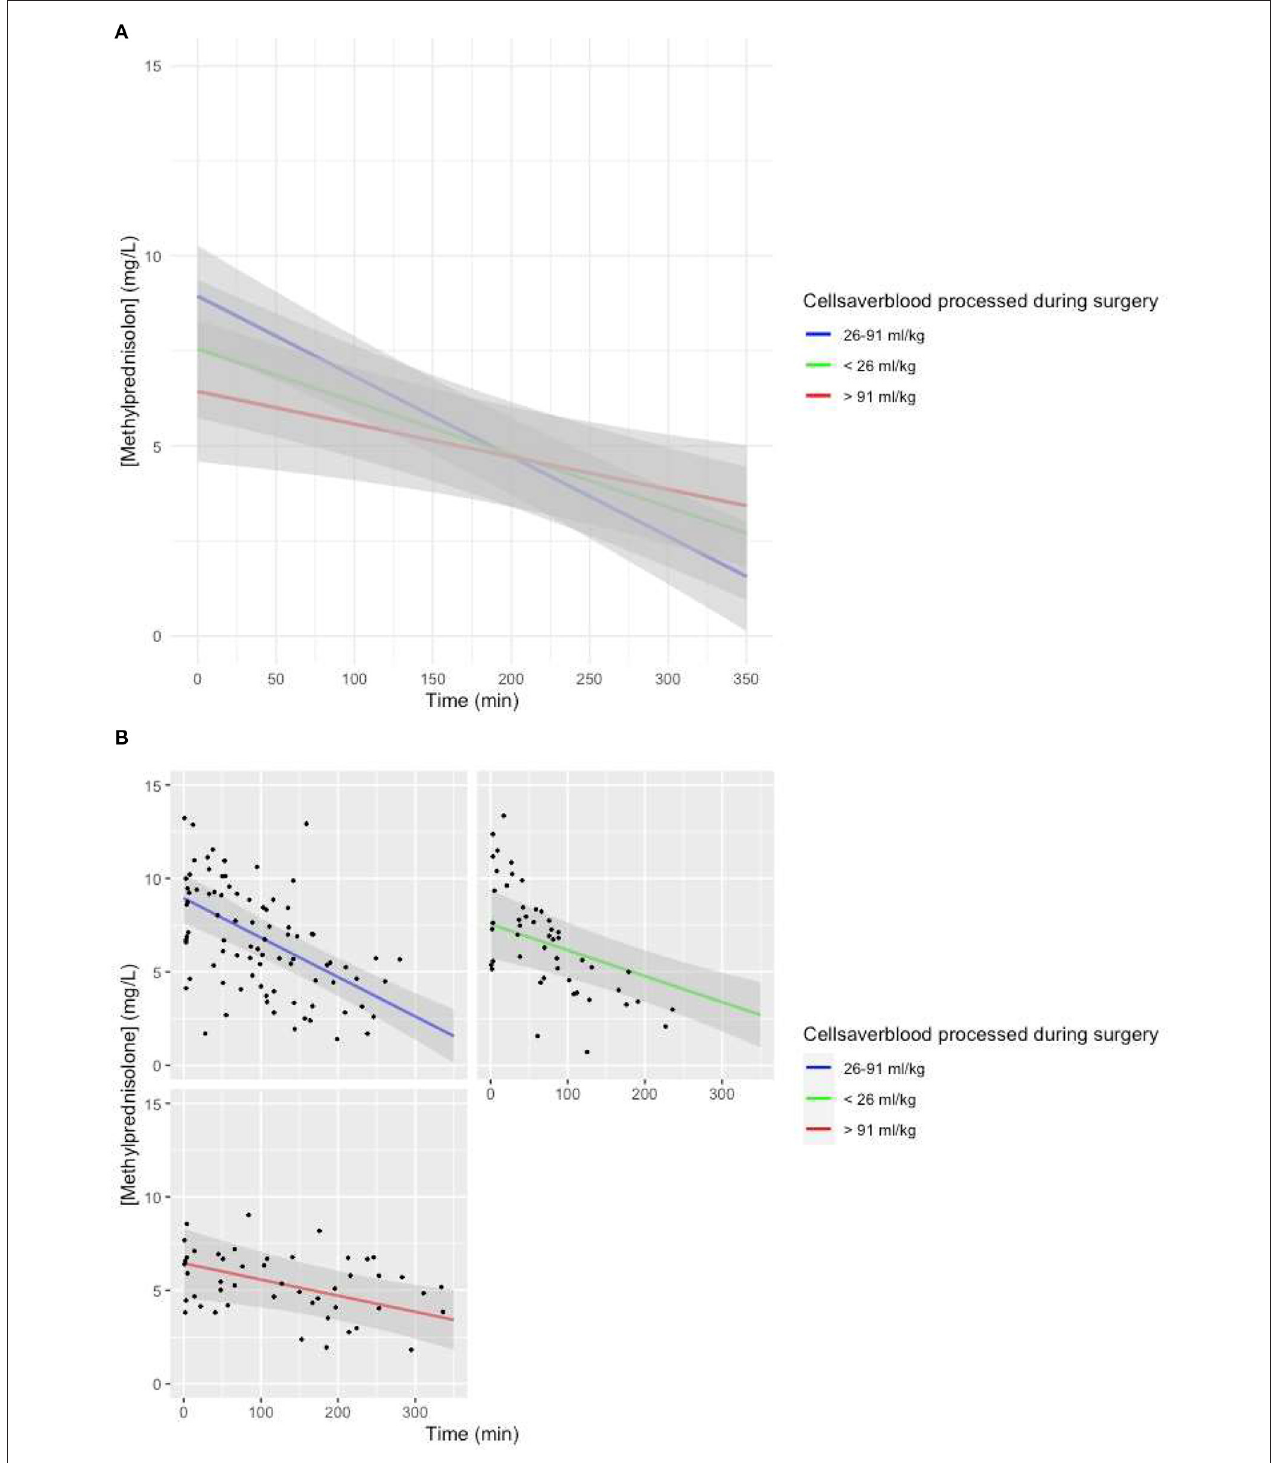
FIGURE 5 | (A) Predicted MP concentration (mg/L) vs. time (min) for the volume of cell saver blood processed based on the linear mixed-effects model. Gray ribbon: 95% confidence interval. T = 0: start of CPB. (B) Predicted MP concentration (mg/L) vs. time (min) for the volume of cell saver blood processed based on the linear mixed-effects model. Gray ribbon: 95% confidence interval. T = 0: start of CPB.